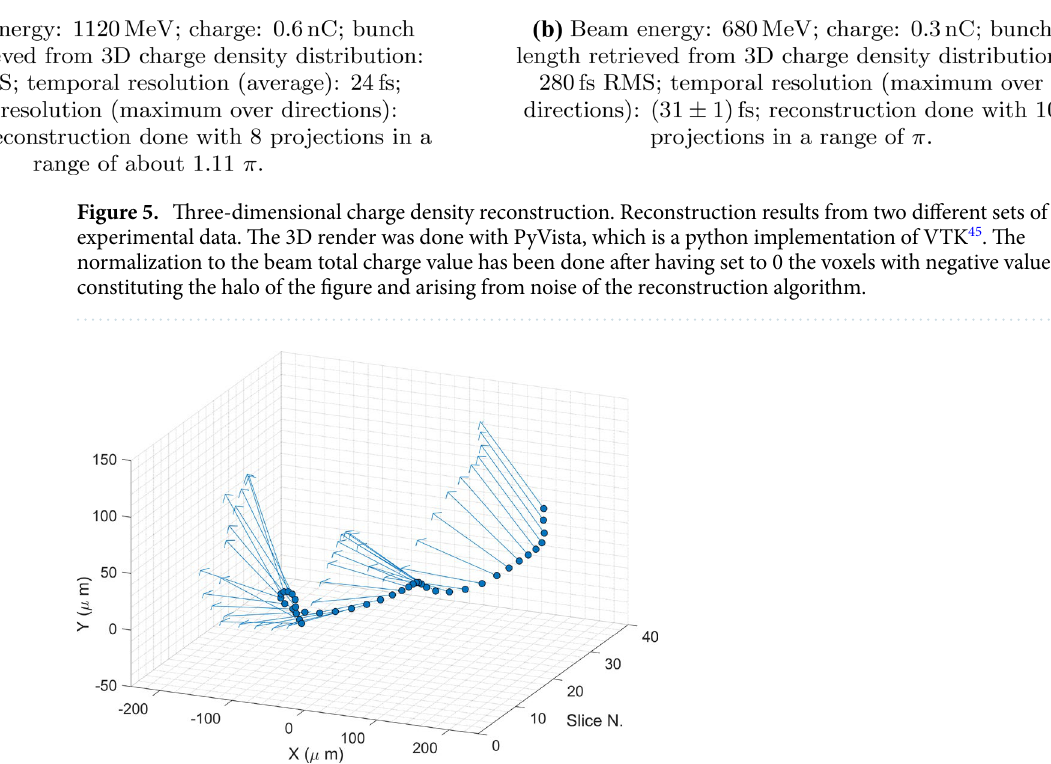
Figure 6. Centroids (dark blue points) and orientation of the x–y correlation (light blue arrows) in the longitudinal slices of the electron bunch calculated from the beam reconstructed in Fig. 5b. The slices have length of 31 fs and increasing running number scrolling from the head to the tail the beam